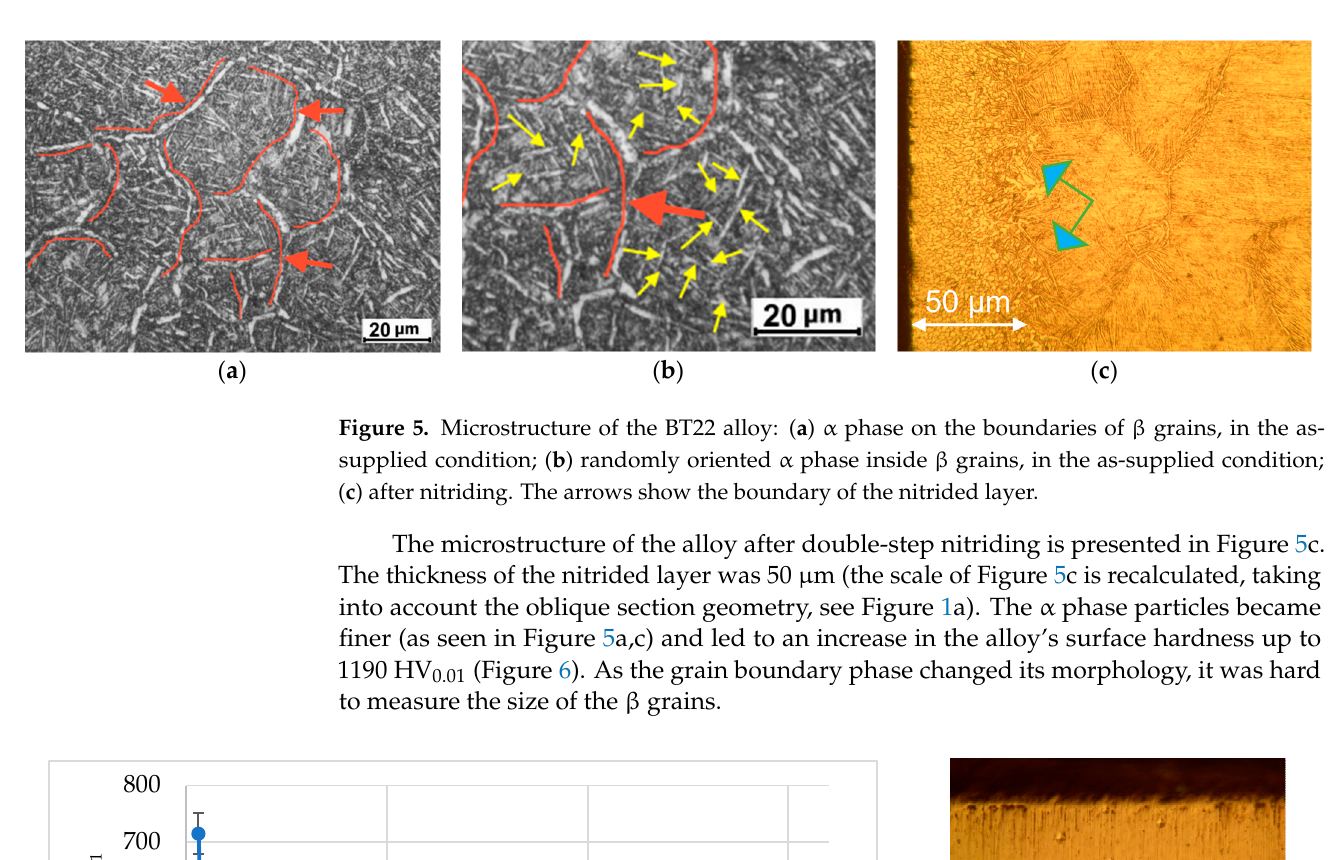
supplied condition; ( b ) randomly oriented α phase inside β grains, in the as-supplied condition; ( c ) after nitriding. The arrows show the boundary of the nitrided layer.